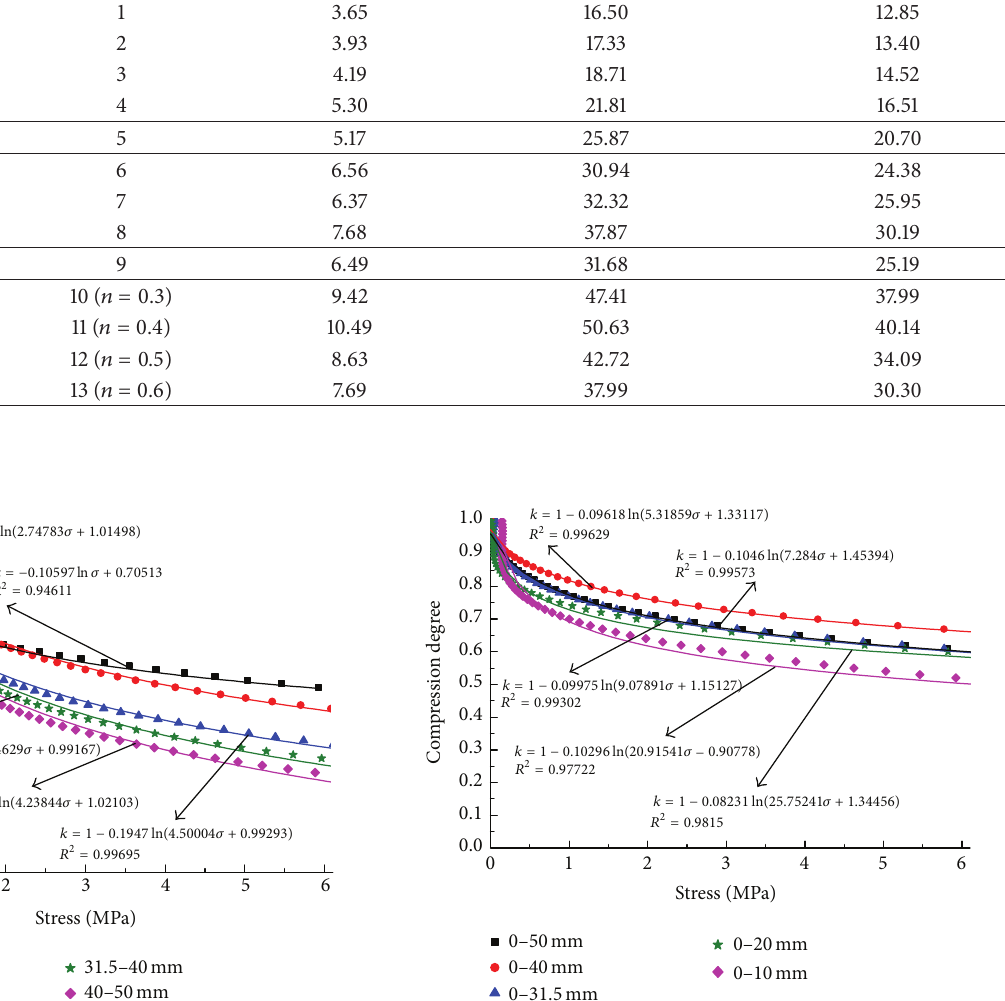
Figure 5: Stress-compression degree for single-graded samples.